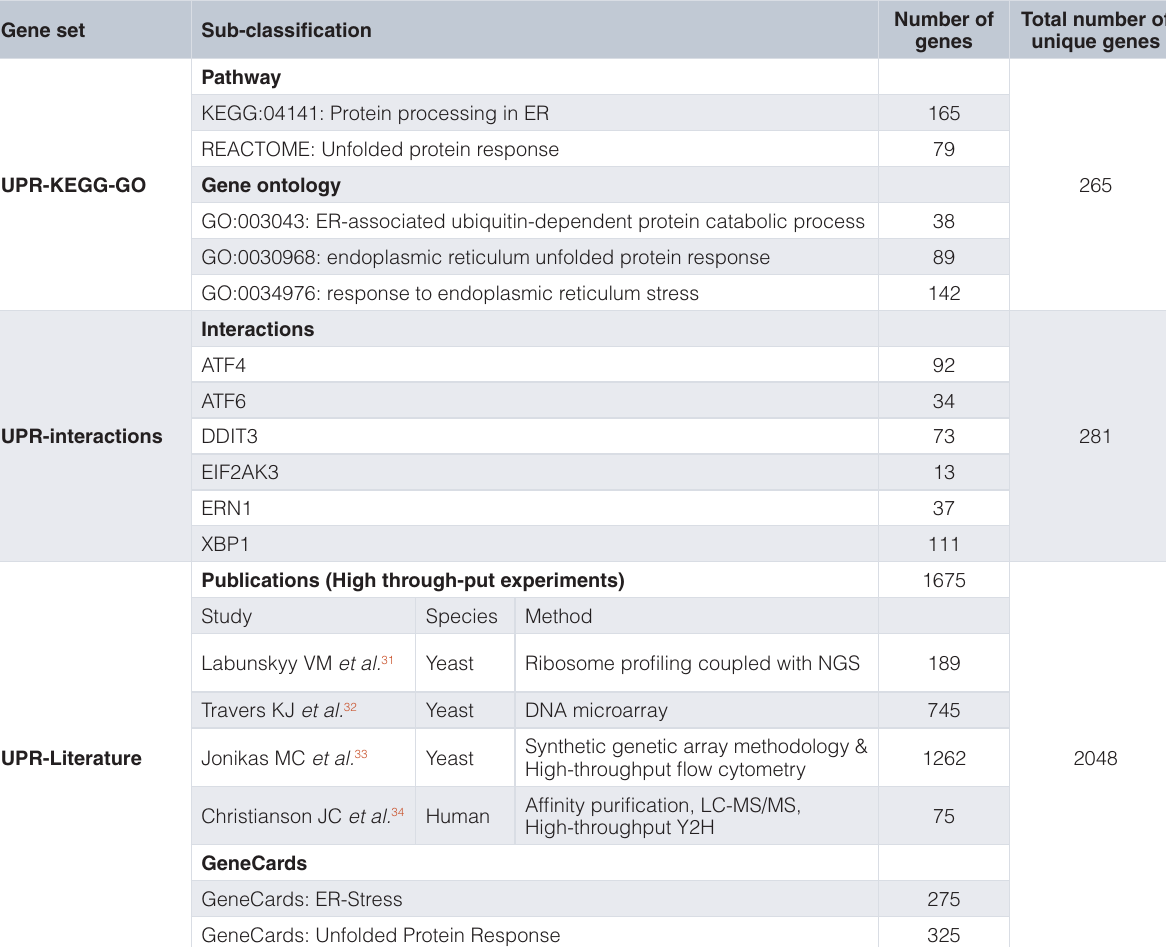
Table 1. Data sources used to compile UPR gene sets. Gene